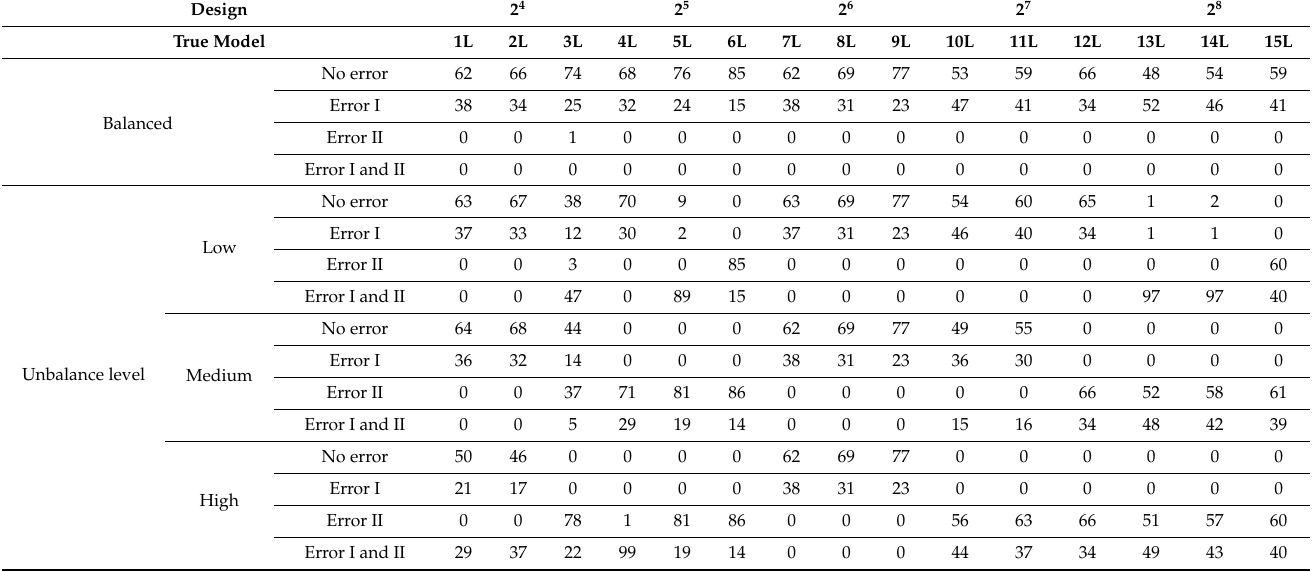
Table 7. % Error behavior with low noise.